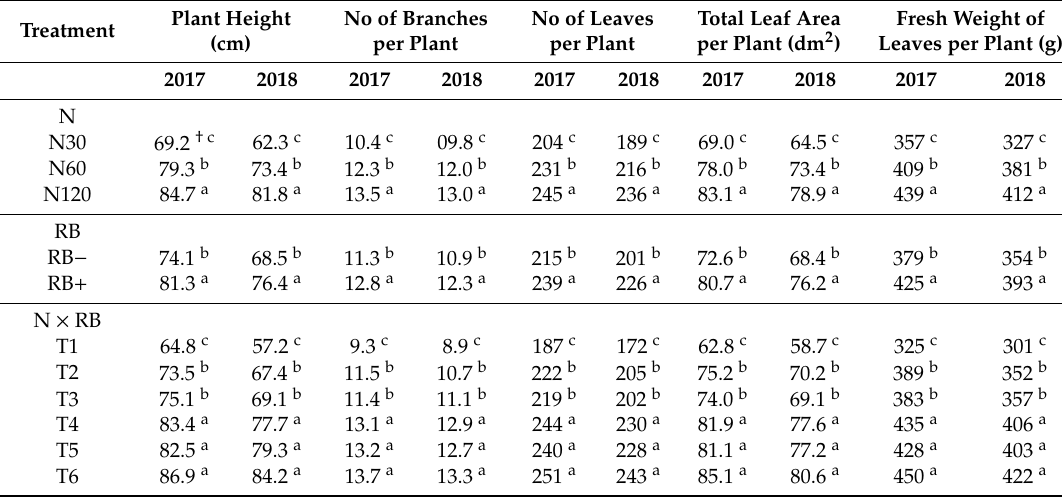
Table 2. E ff ects of mineral nitrogen fertilizer (N) and Rrhizobacterein biofertilizer (RB) on morphological parameters of Egyptian henbane in 2017 and